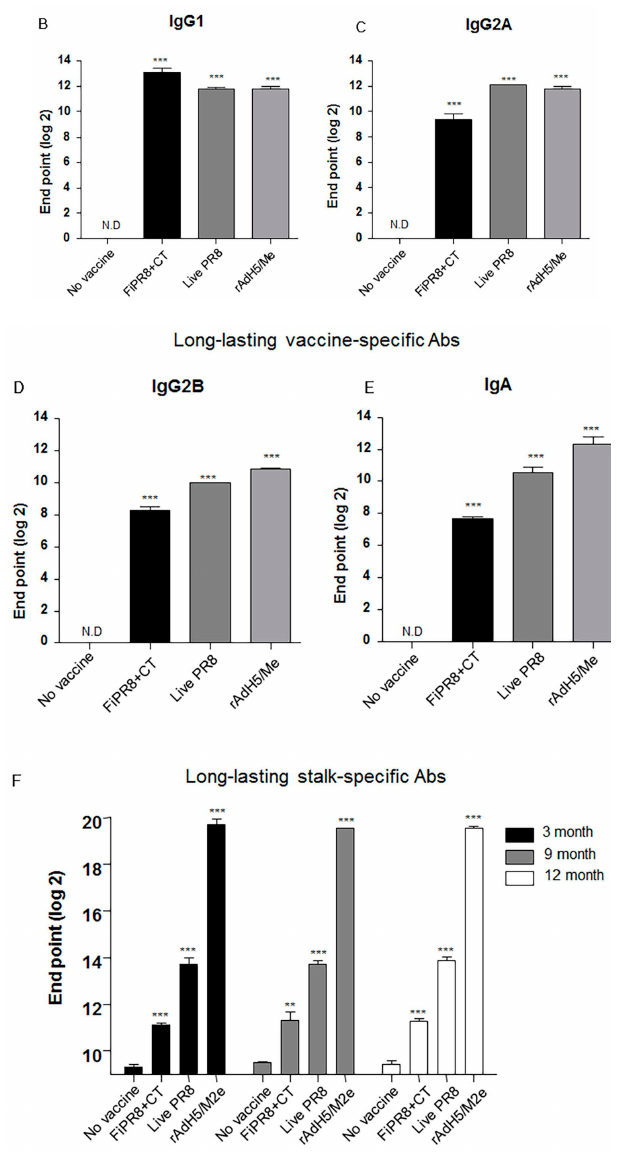
Figure 5. Intranasal immunization with adenovirus-vectored influenza vaccine induced long-lived HA stalk-specific humoral immunity. To detect long-term stalk-specific antibody responses, Balb/c mice were intranasally immunized with FiPR8+CT, live PR8, or rAdH5/M2e. Sera were collected from immunized mice at twelve moths post-immunization, and the levels of Th1/Th2 Abs were determined by a Mouse immunoglobulin Isotyping Magnetic Bead Panel assay (Millipore, Millipore Corporation, Billerica, MA, USA) ( B – E ). To examine the duration of the vaccine-specific and stalk-specific antibody responses, sera were collected from the immunized mice at three, nine, or twelve months post-immunization. The levels of vaccine-specific and stalk-specific Abs were determined by ELISA using plates coated with H1N1 ( A ), or baculorvirus-expressed cH9/1 protein ( F ). The values represent the mean ± SEM (vertical bars) end point ELISA antibody titers determined from five mice per group (*** p < 0.0001).